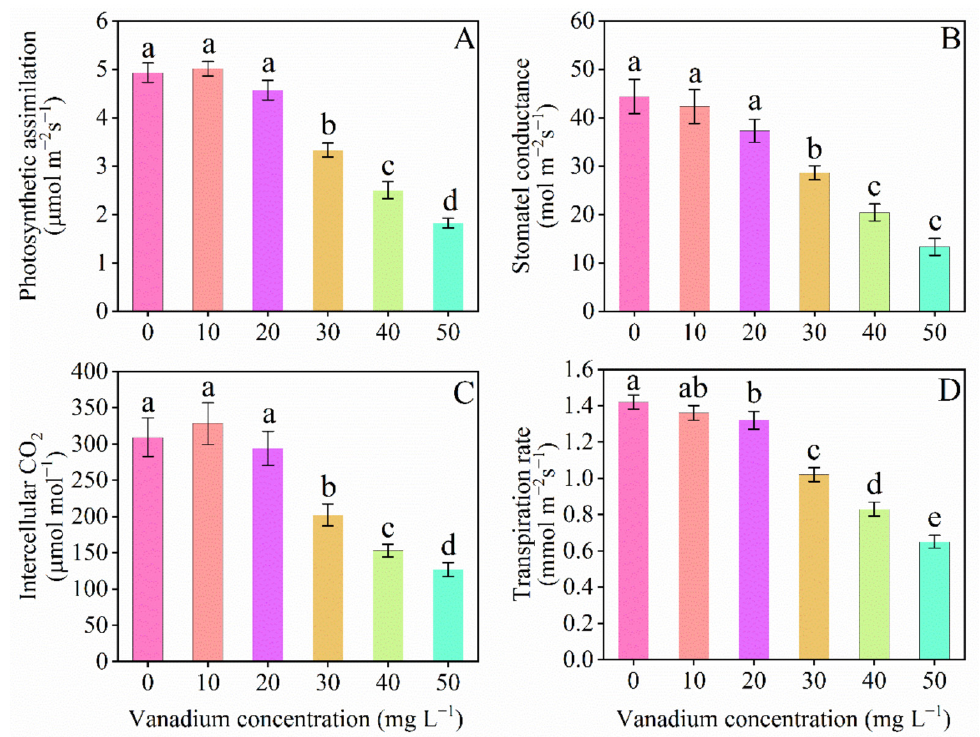
Figure 5. Effect of vanadium on leaf gas exchange elements [Photosynthetic assimilation ( A ), stomatal conductance ( B ), Intercellular CO 2 ( C ), and transpiration rate ( D )] in pepper seedlings. Means ± SE, n = 4, significant differences are exhibited by lowercase letters (at p < 0.05), according to Fisher’s least significant difference